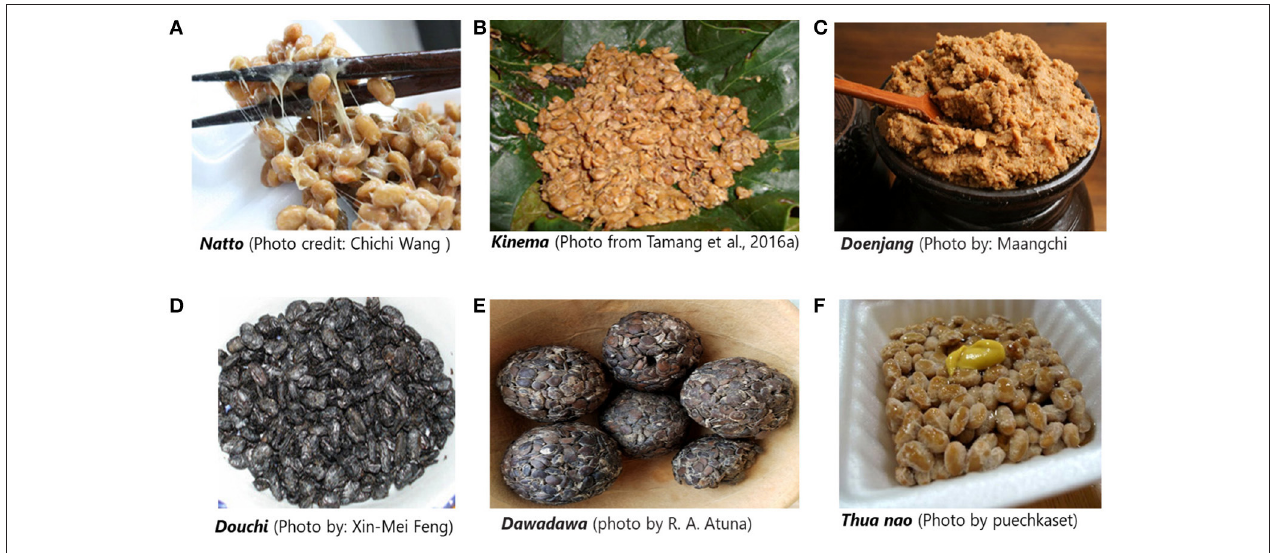
FIGURE 3 | Examples of traditional AFFs in Africa and Asia. (A) Natto (Photograph credit: Chichi Wang), (B) Kinema (Photograph from Tamang et al., 2016a), (C) Doenjang (Photograph by Maangchi), (D) Douchi (Photograph by Xin-Mei Fang), (E) Dawadawa (Photograph by R. A. Atuna), and (F) Thua nao (Photograph by